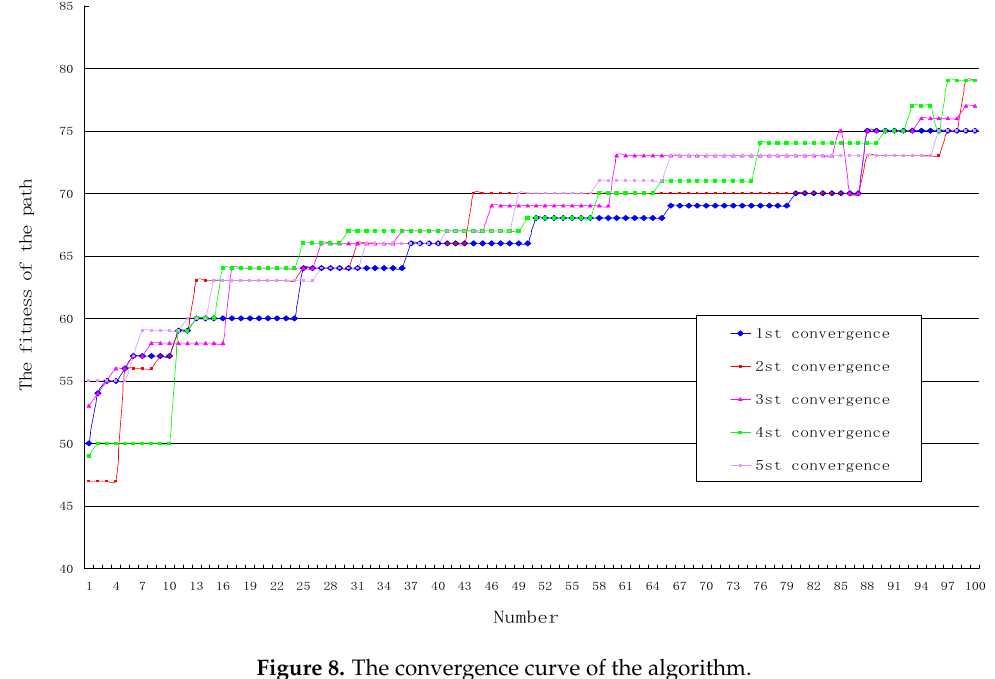
Figure 8. The convergence curve of the algorithm. Table 8. The convergence rate.